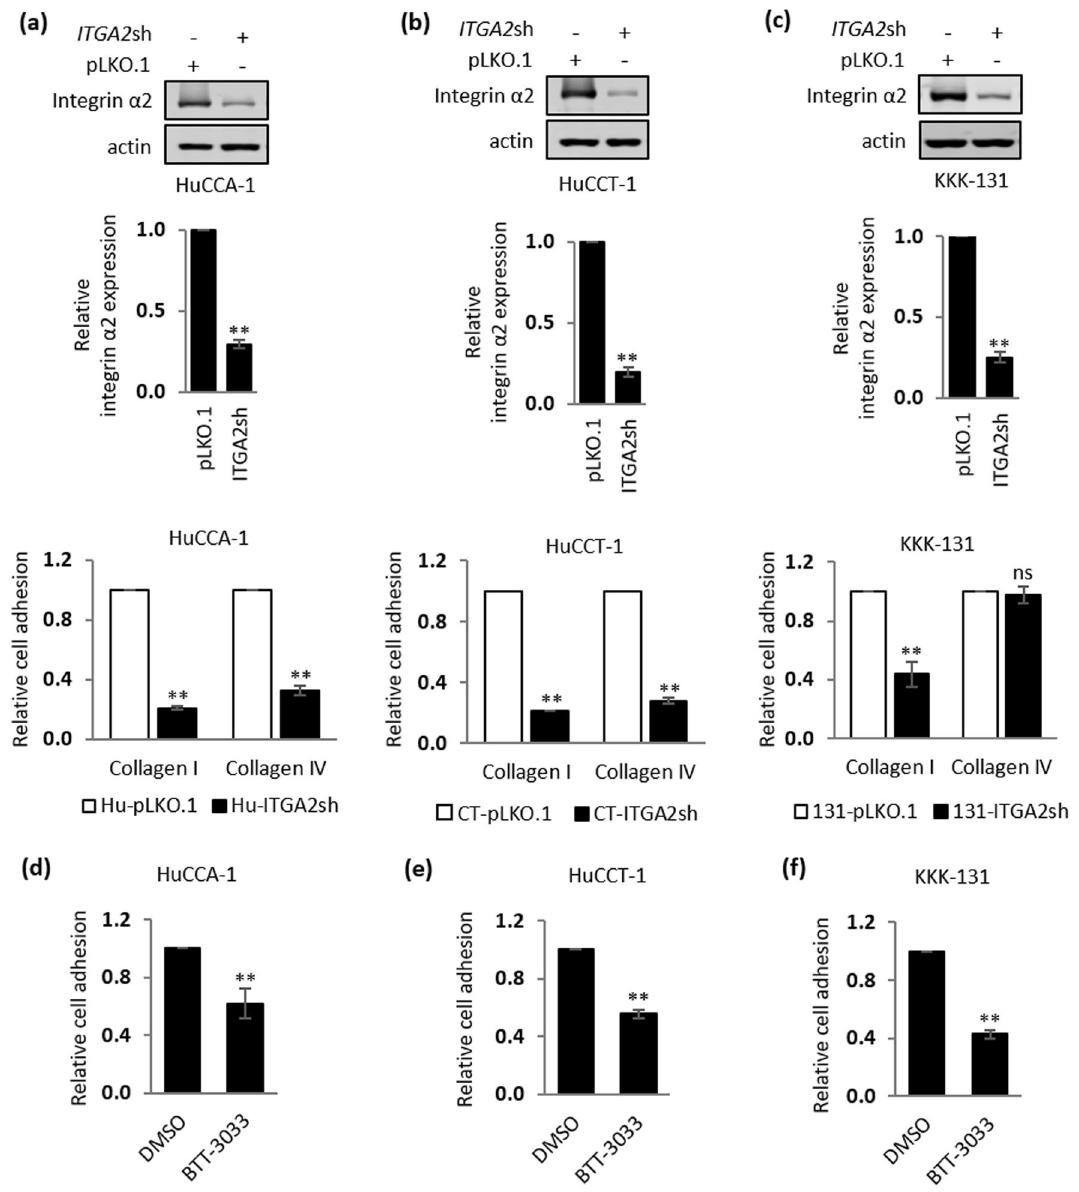
Figure 4. Integrin α2 is critical for a direct interaction between iCCA cells and collagen type I. ( a ) HuCCA- 1, ( b ) HuCCT-1 and ( c ) KKK-131 cells stably expressing pLKO.1 vector control or pLKO.1- ITGA2 shRNA ( ITGA2 sh) were subjected to a cell adhesion assay on 10 μg/mL collagen type I or IV for 1 h. Top: Representative immunoblot analysis against integrin α2. Actin serves as a loading control. Middle: Quantification of immunoblot analysis against integrin α2. Bottom: Quantification of cell adhesion assays. ( d ) HuCCA-1, ( e ) HuCCT-1 and ( f ) KKK-131 cells ± DMSO or 5 μM BTT-3033 (an integrin α2β1 selective inhibitor) were subjected to 1 h adhesion assay. The bar graphs represent the mean ± SD from at least three independent experiments. The Student’s t-test was used to calculate p -value, compared with a control group. ns, not significant; ** p <